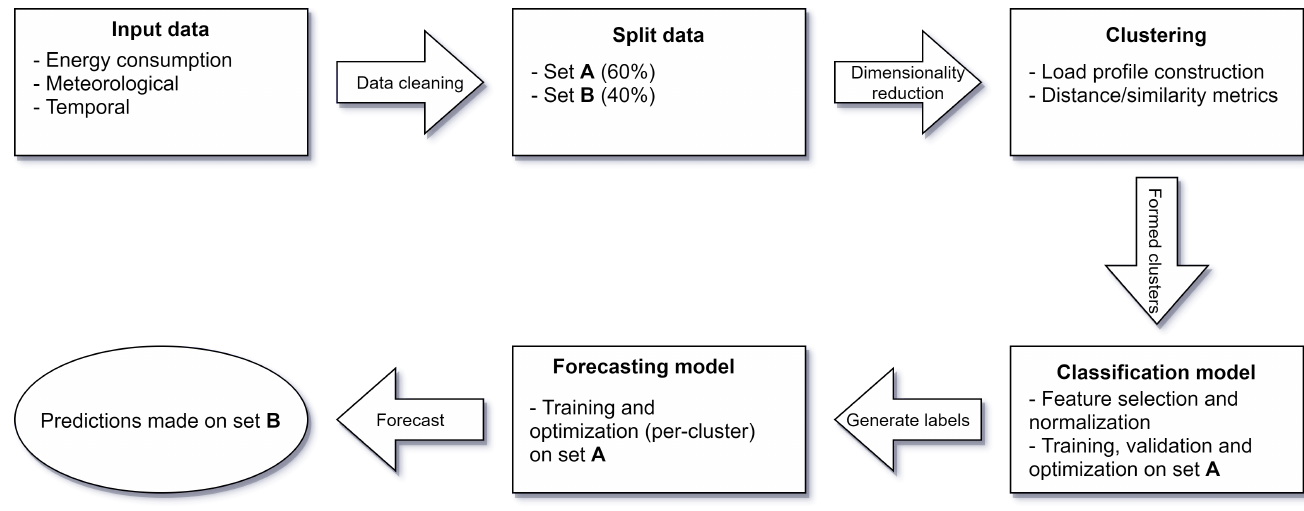
Figure 1. High-level overview of the steps pertaining to our